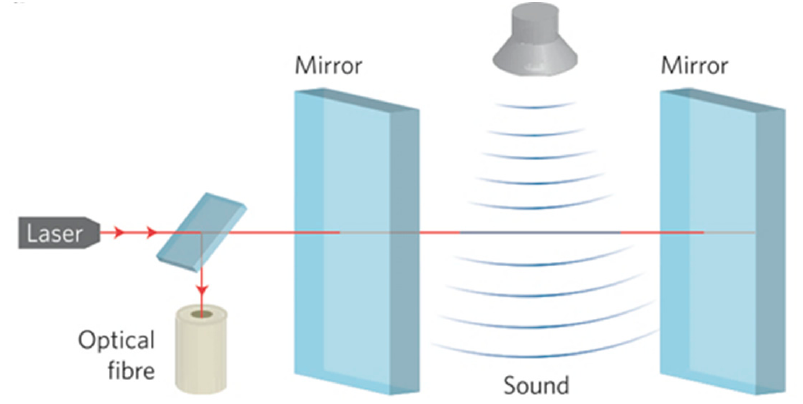
Figure 8. Schematic of the membrane-free optical microphone by Xarion [77].